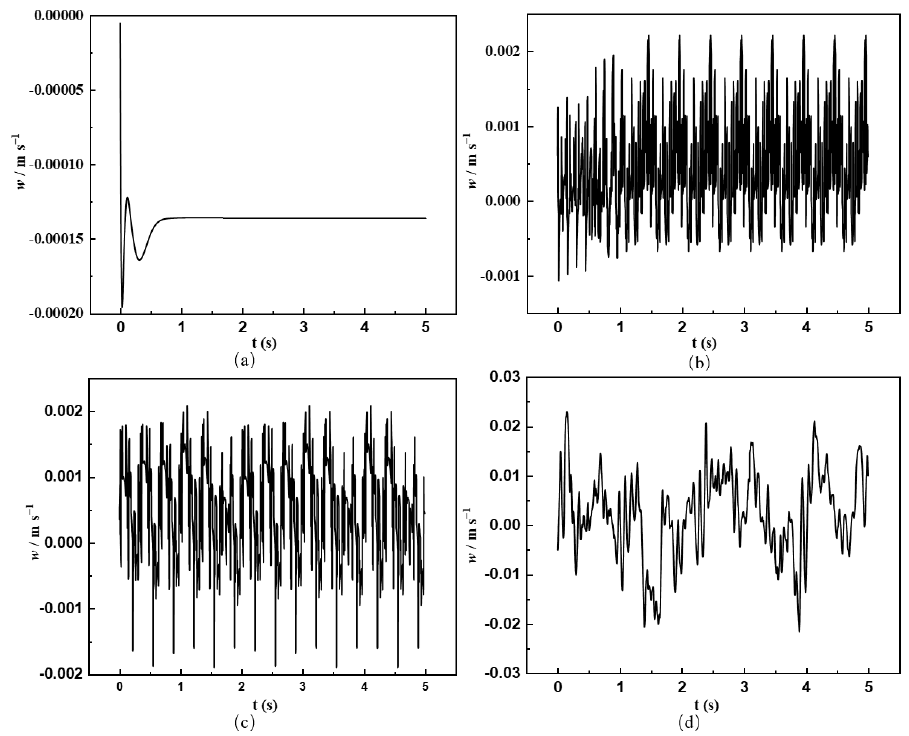
Figure 12. The partial velocity w against time: ( a ) f = 1 Hz; ( b ) f = 3 Hz; ( c ) f = 5 Hz; ( d ) f = 10 Hz.